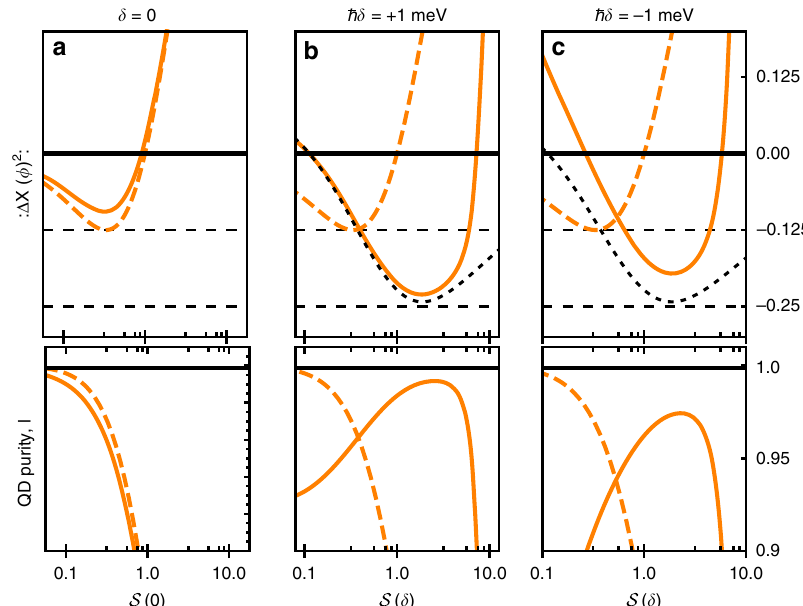
Fig. 2 Quadrature variance and exciton purity. Normally ordered quadrature variance : Δ X ( ϕ ) 2 : on ( a ) and off ( b , c ) resonance. The solid curves are calculated using the full phonon theory and the dashed curves are calculated in the absence of phonons as in Eq. (3). The gridlines indicate the values : Δ X ( ϕ ) 2 : = − 0.125 (maximum level of squeezing obtainable in the absence of phonons) and : Δ X ( ϕ ) 2 : = − 0.25 (upper bound on the level of squeezing obtainable from a two-level system). The black dotted curve shows the analytic approximation in Eq. (6). The lower plots show the purity of the quantum dot excitonic state l , with l = 1 corresponding to a minimum uncertainty state of the emitted fi eld. Parameters are as in Fig. 1. Off-resonance ( ħ δ = ±1 meV), the minimum and maximum scaled driving strengths cover the range s ~ 10 5.5 – 10 7.5 , while in the resonant case Sð 0 Þ ¼ s by de fi